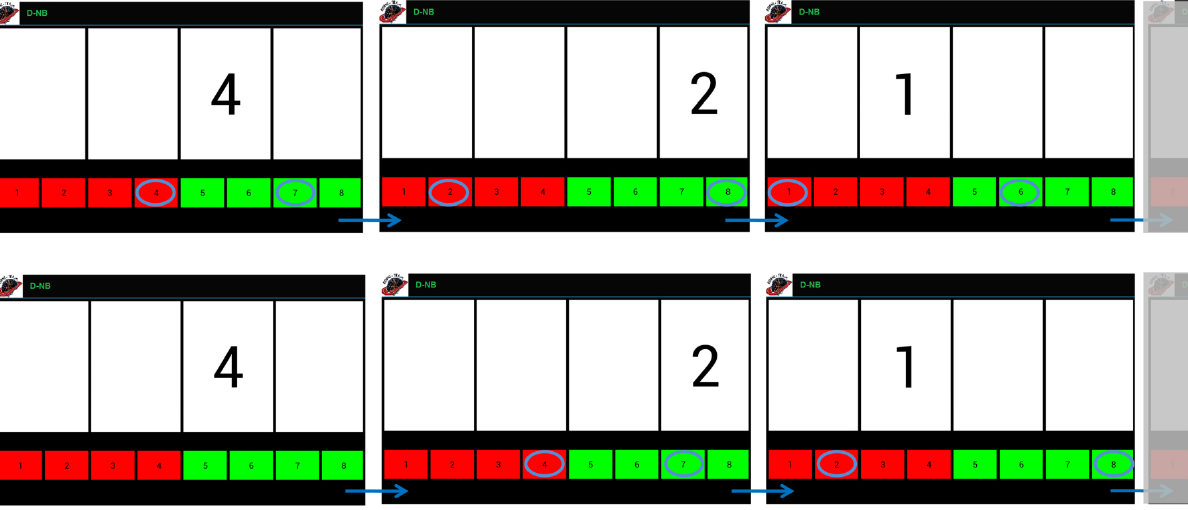
Figure 3. Examples of the dual N-back (D-NB) exercise. The upper panel shows the D-NB difficulty level when N=0 ("Dual" 0-back), whereas the lower panel shows N=1 ("Dual" 1-back). Here, patients have to watch the stimulus, memorize it, and touch the buttons corresponding to the digit and cell deferred by one new stimulus. Task-specific parameters are N (minimum 0; maximum not defined), and the rate of stimuli presentation, both susceptible to modifications by the adaptive working load